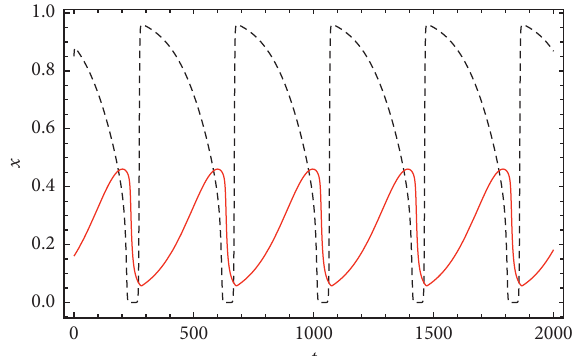
+ τ � 16 > τ , and then reach the periodic solutions of system (32) (time series with the 1 2 00